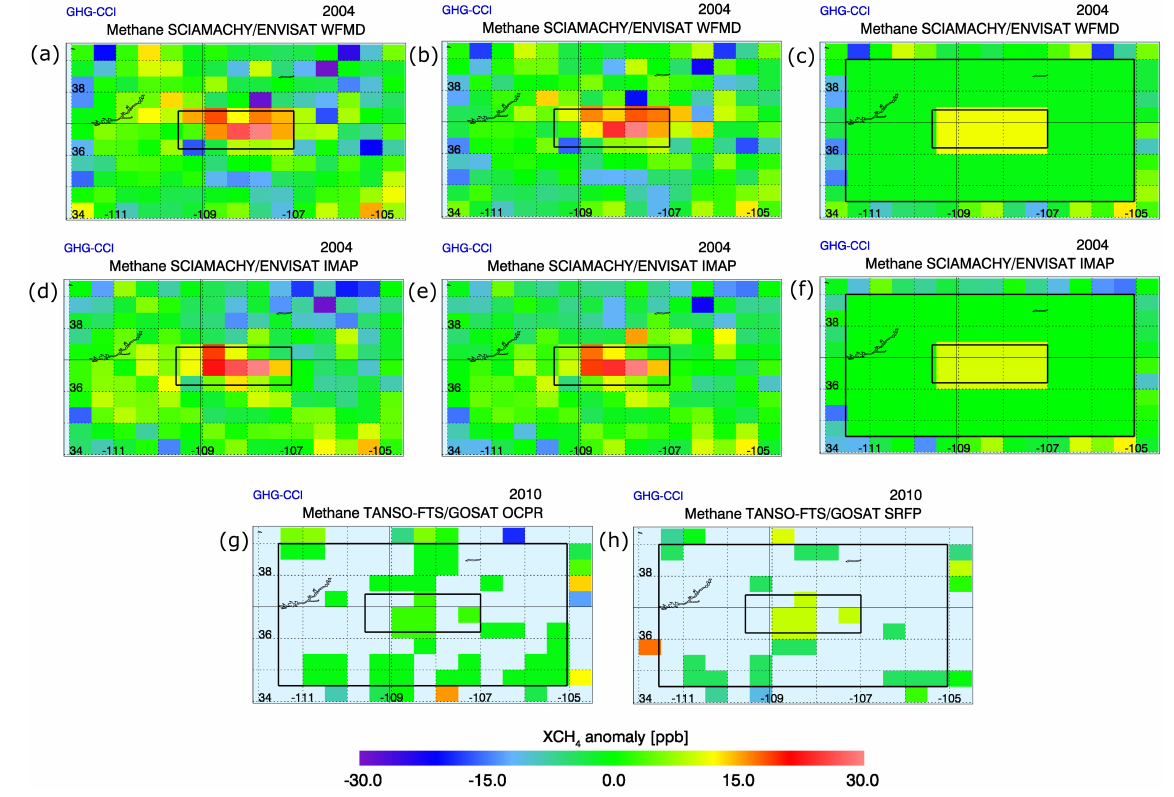
Figure 14. Satellite-derived X CH 4 anomalies (i.e. the mean value of X CH 4 has been subtracted) in and around the Four Corners region. (a, b, c) SCIAMACHY WFMD year 2004 X CH 4 anomaly at 0.5 ◦ × 0.5 ◦ resolution. (a) Originally gridded data. The black rectangle indicates the assumed source area (taken from Kort et al., 2014). (b) As (a) but after elevation correction (see main text for details). (c) As (b) but replacing the individual X CH 4 values by their averages in the indicated source region (inner rectangle) and its surrounding (outer rectangle). The difference between these two values defines the methane enhancement of the source region, i.e. (cid:49)X CH 4 . (d, e, f) As top row but for IMAP X CH 4 . (g, h) As last column of first two rows but for GOSAT OCPR ( g ) and SRFP ( h ) for the year